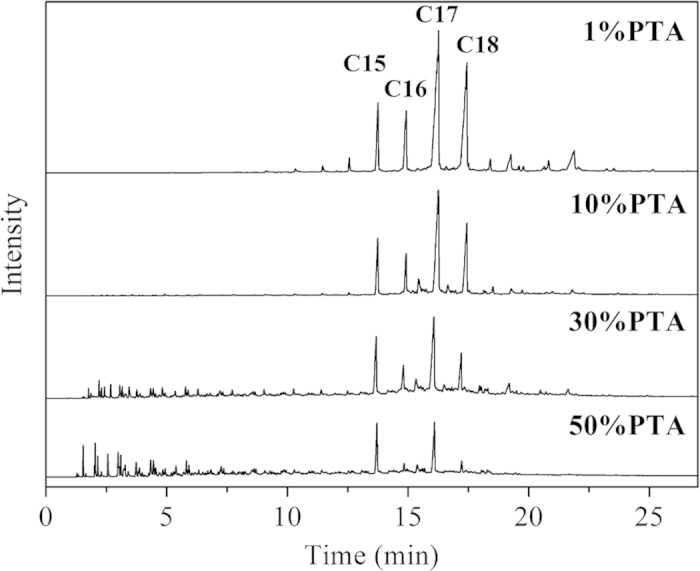
GC charts of product oil from hydroprocessing of Jatropha oil over synthetic Ni-PTA(1–50)/Al2O3 catalysts at 360 °C, 3.0 MPa, 0.8 h−1.